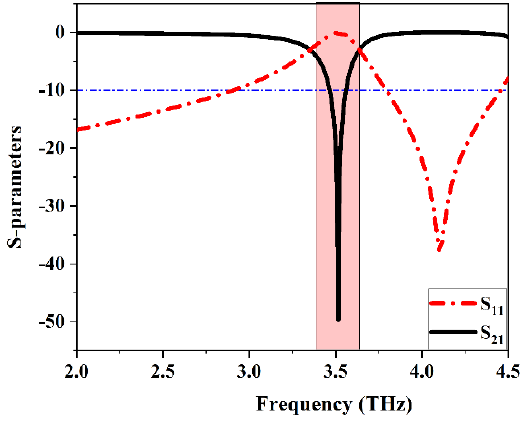
Figure 12. Simulation set up and dimensions for the Dumbbell-structure MTM unit cell.